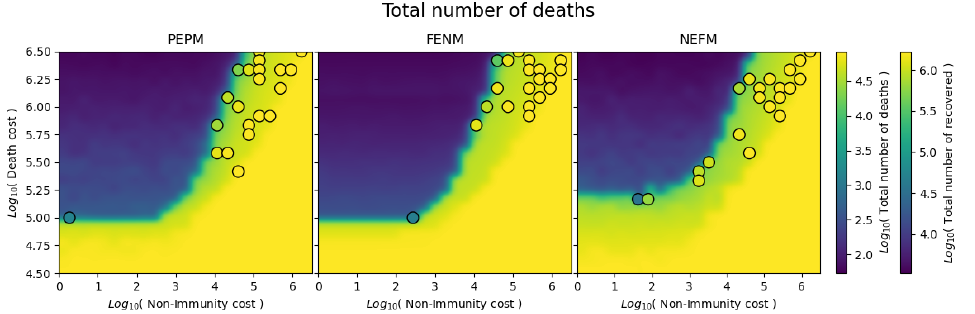
Figure 9. Heatmap showing number of deaths as a function of death and non-immunity costs under PEPM, FENM, and NEFM algorithms, respectively. Pareto optimal solutions are indicated by hollow dots, and the dot colors correspond to number of recovered according to the color scale at the far left. The figure shows that all Pareto optimal solutions occur in the transition region between death-nonimmune cost combinations producing few deaths (blue region) and those corresponding to many deaths (yellow